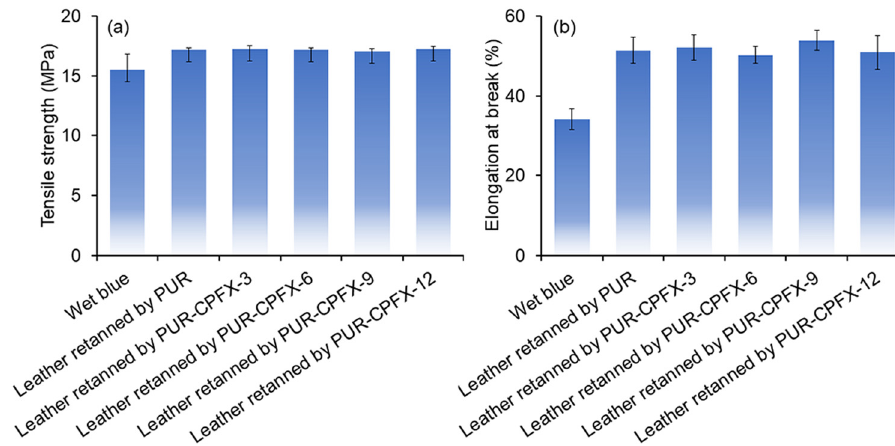
Figure 3: ( a ) Tensile strength and ( b ) elongation at break of Wet blue and leather retanned by PUR and PUR -